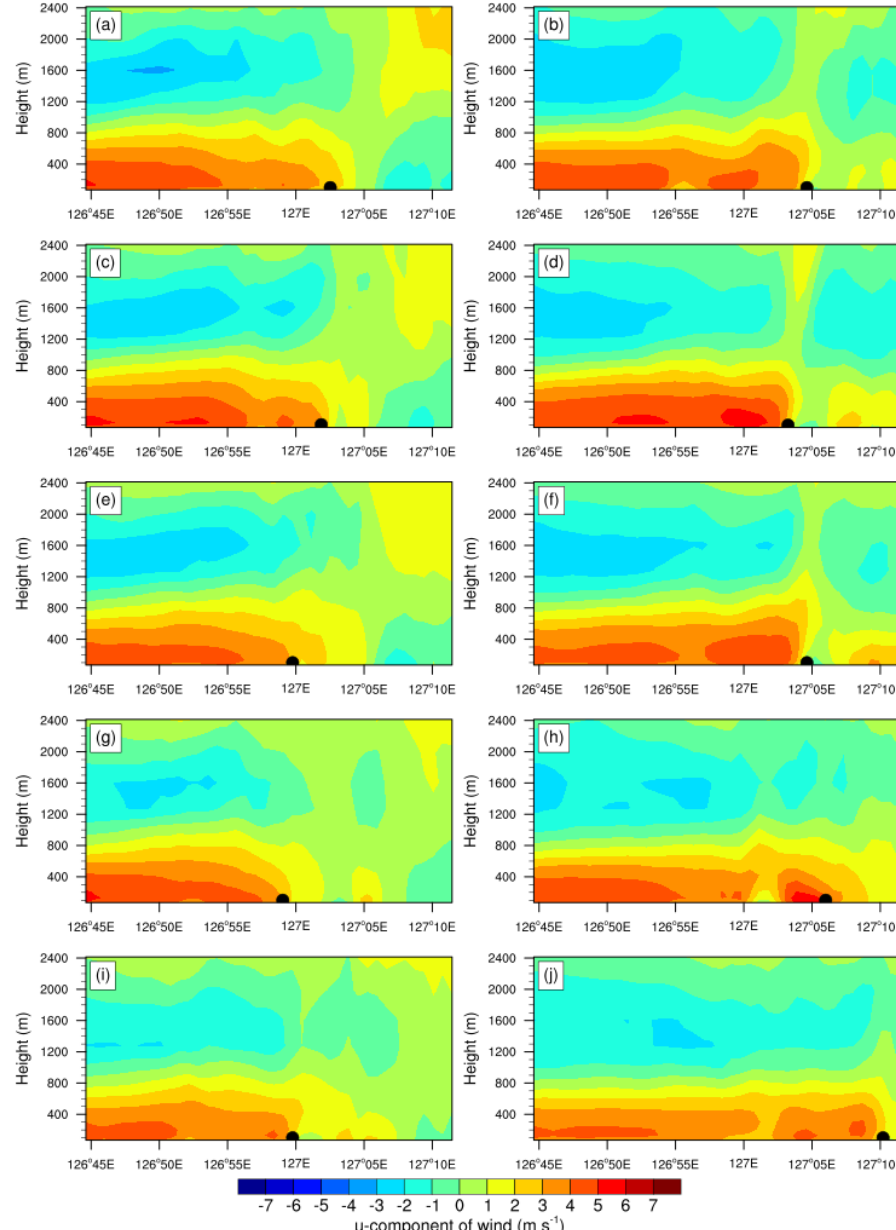
Figure 13. Longitude-height cross-section of meridional-averaged u -component of wind (m s −1 ) in analysis domain for ( a , b ) CNTL, ( c , d ) LB, ( e , f ) NA, ( g , h ) NALB, ( i , j ) NOURBAN at 1600 ( a , c , e , g , i ) and 1700 ( b , d , f , h , j ) LST. The black dots indicate the location of the SBF.